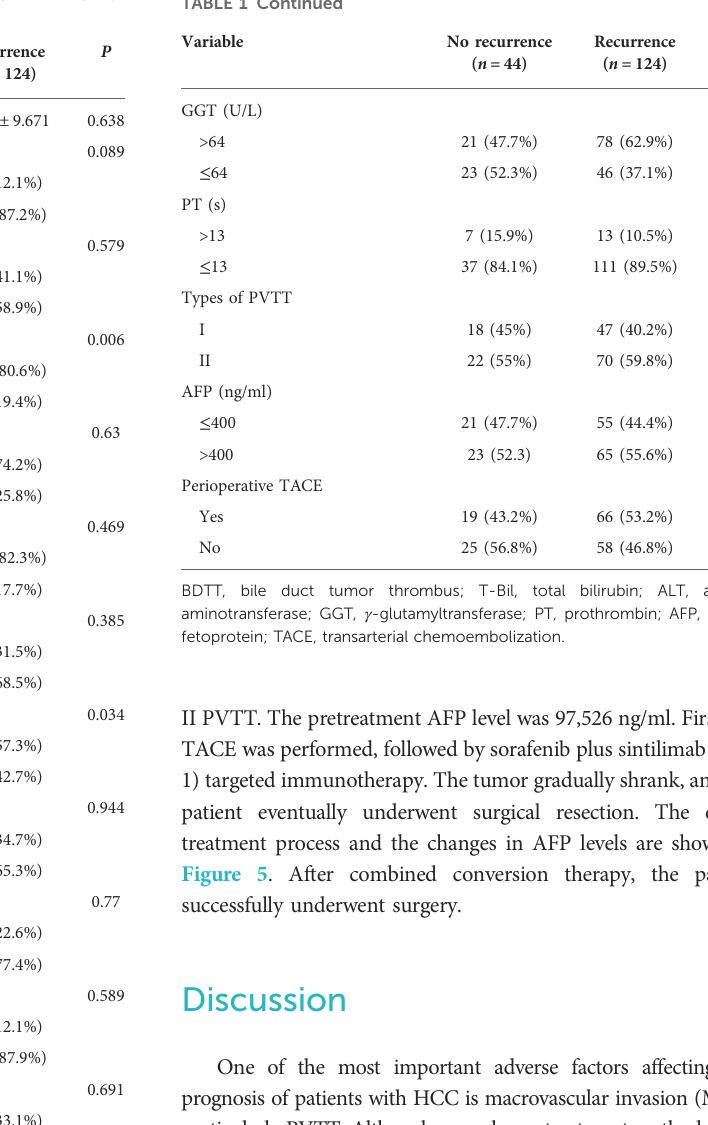
Figure 5 . After combined conversion therapy, the patient successfully underwent surgery.